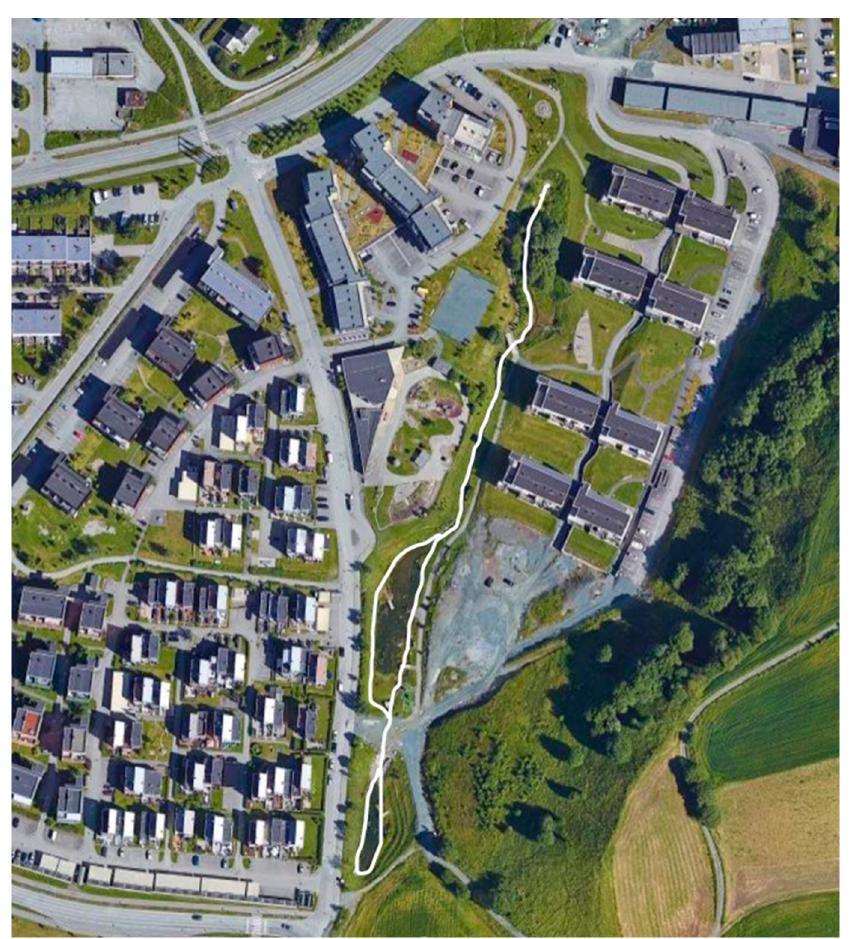
Figure 2. Aerial view of the Blaklibekken site (Maxar Technologies, map data © 2022).